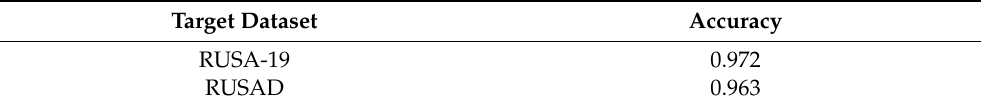
Table 9. Accuracy of target datasets with transfer learning from training the model on concatenated source